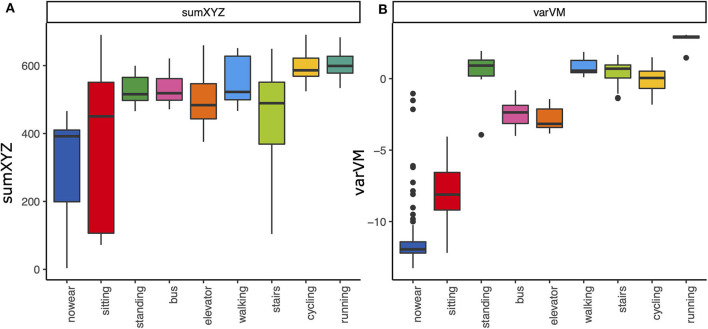
Smartphone metrics and physical activities. Boxplots of the smartphone metrics (A) sumXYZ and (B) varVM during different activities. Both metrics also tended to increase with the activity intensity.